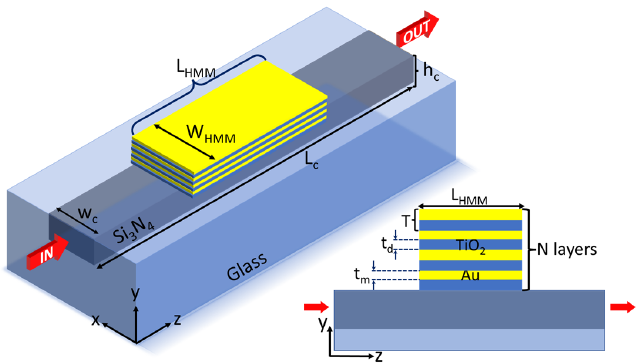
Figure 1. Schematic of the integrated device. Hyperbolic metamaterial consisting of a periodic array of Au-TiO 2 thin layers of thickness t m and t d , respectively, are placed on top of a Si 3 N 4 waveguide ( w c = 750 nm, h c = 250 nm) buried in a glass substrate. Photonic modes propagate through the waveguide along the z direction from the input (IN) and the transmission spectrum is measured at the output (OUT) face of the